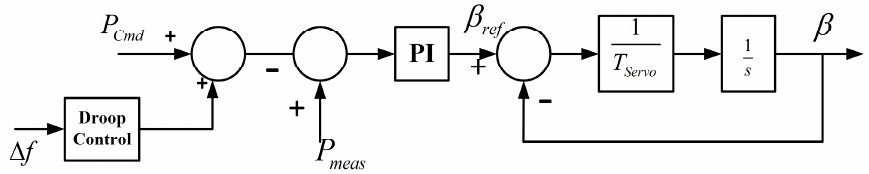
Figure 15. Pitch angle controller.